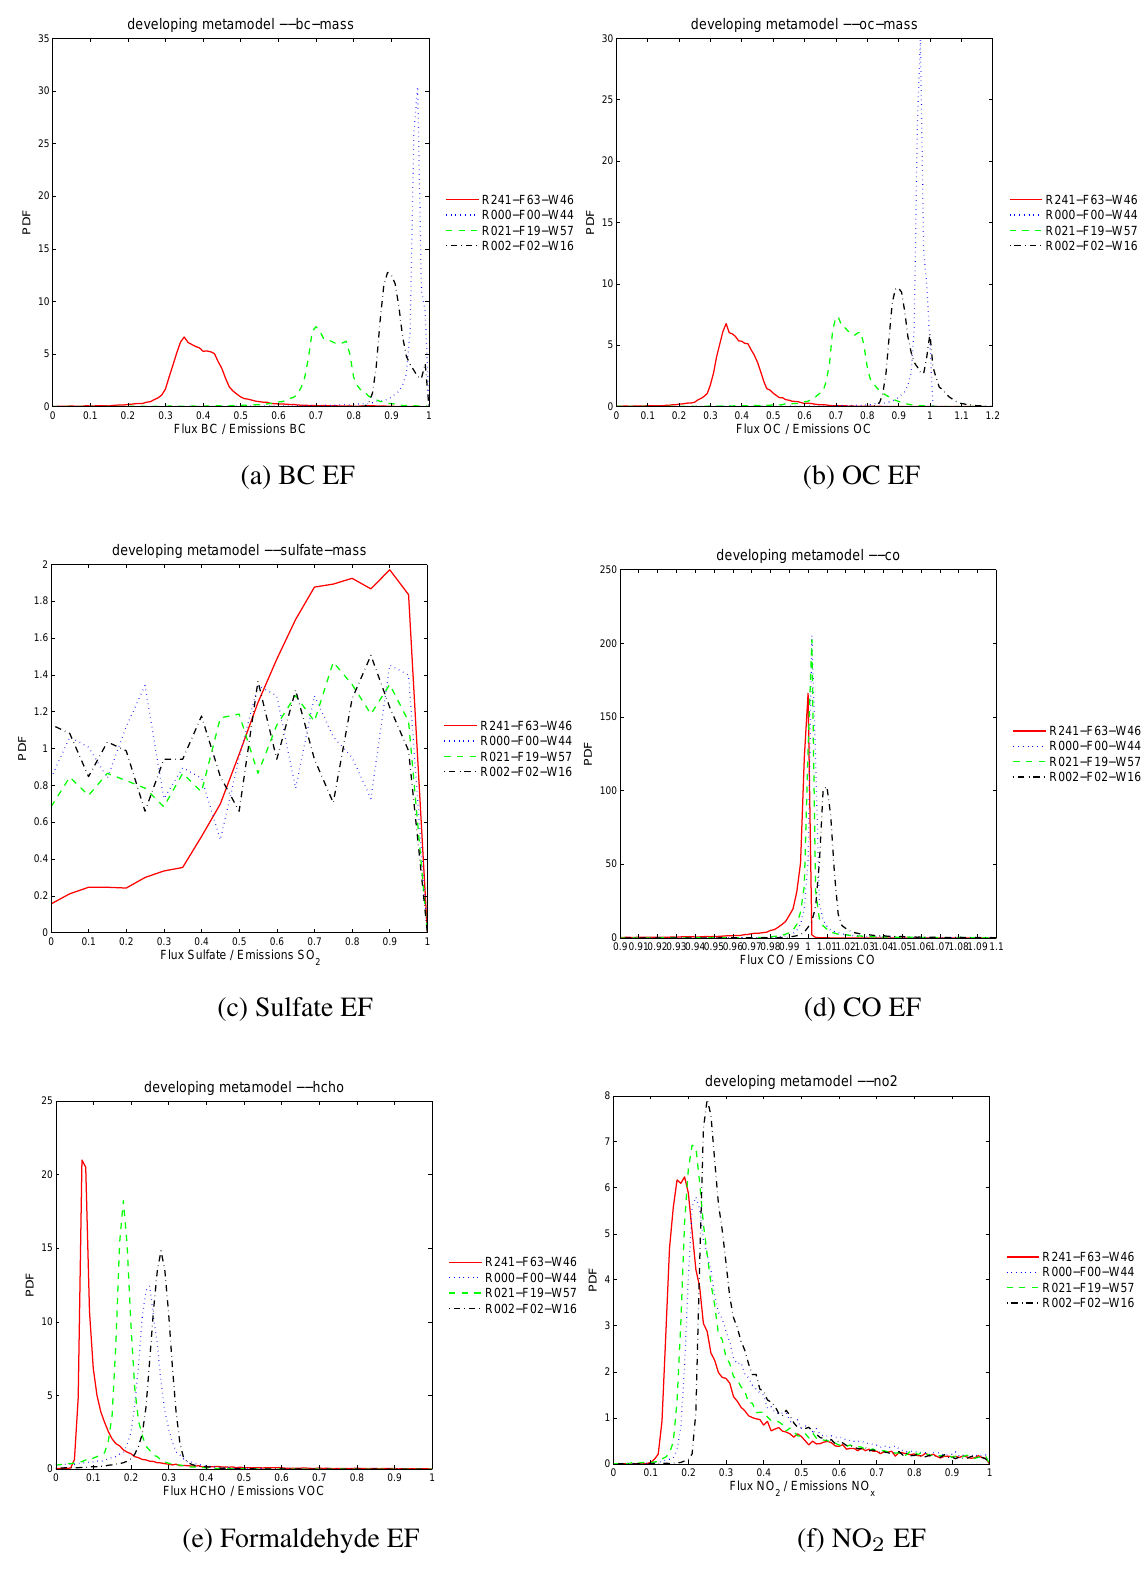
Fig. 11. These are the PDFs of the total urban area EFs (Eq. 8), from the Developing metamodel. For inputs, please refer to Fig. 5. Fig. 11: These are the PDFs of the total urban area EFs 8, from the Developing metamodel. For inputs, please refer to Figure 5